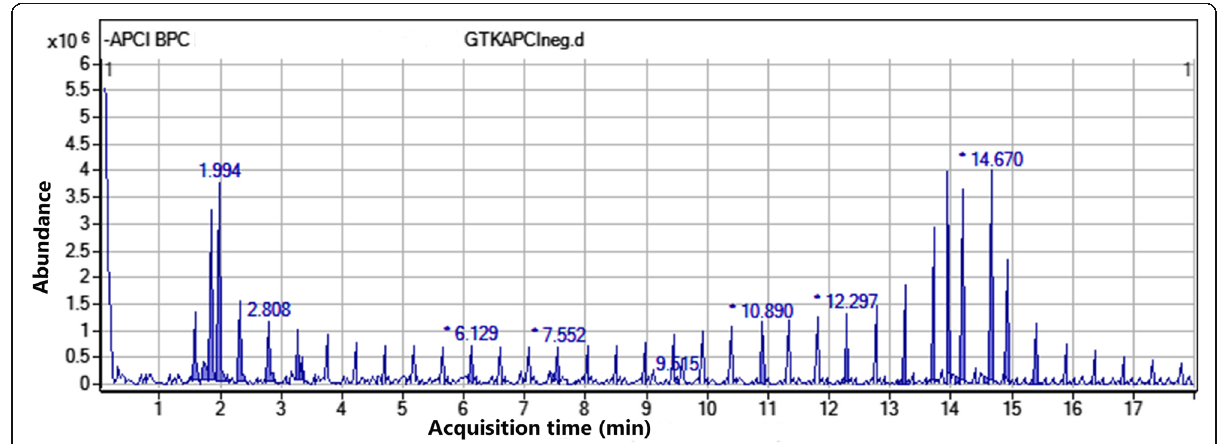
Fig. 4 APCI-MS-base peak chromatogram of GTK in negative